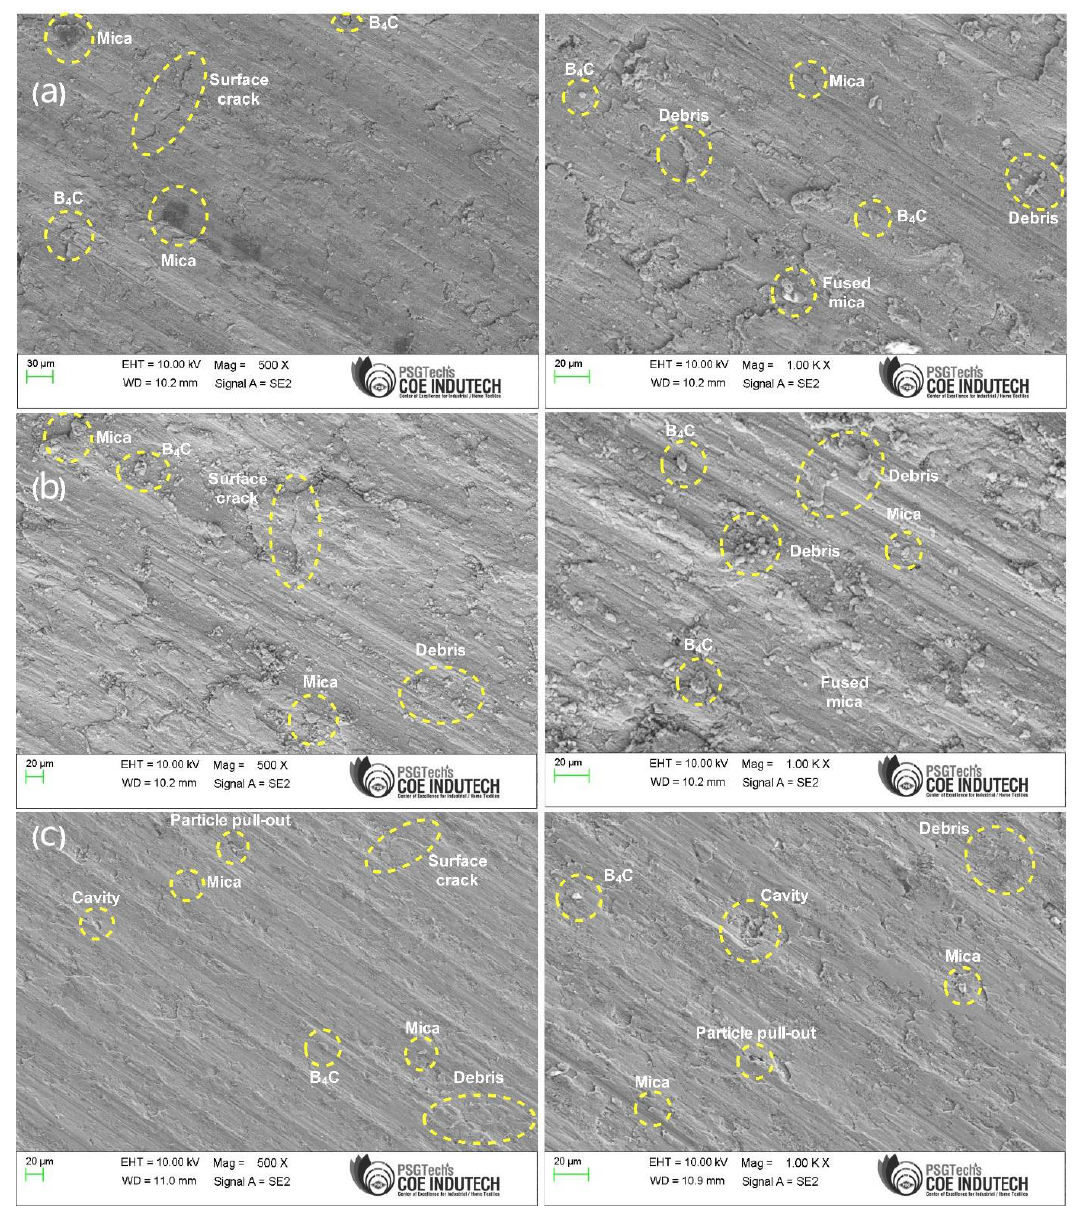
Figure 14. SEM images of drilled holes at A = 2000 rpm, B = 75 mm/min. ( a ) 0 wt.% of mica, ( b ) 3 wt.% of mica, ( c ) 6 wt.% of